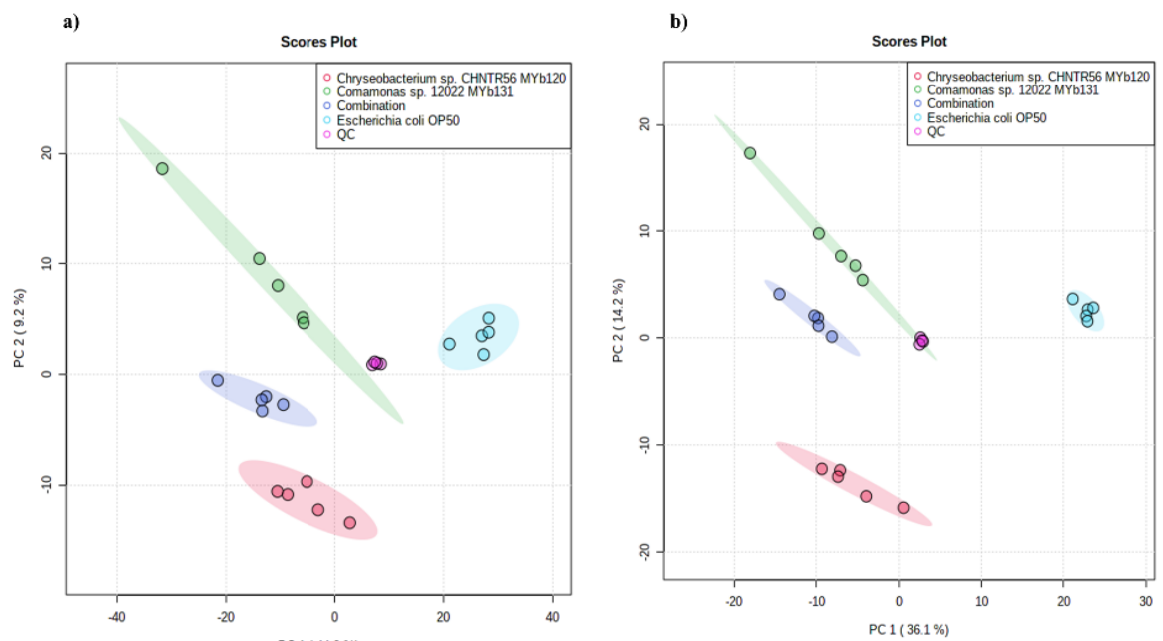
Figure 4. Principal component analysis (PCA). PCA demonstrates the similarity of the samples ( n = 5 per group) based on their metabolite patterns for positive ( a ) and negative ( b ) modes. The QC samples are almost identical, indicating the robustness for each injection.